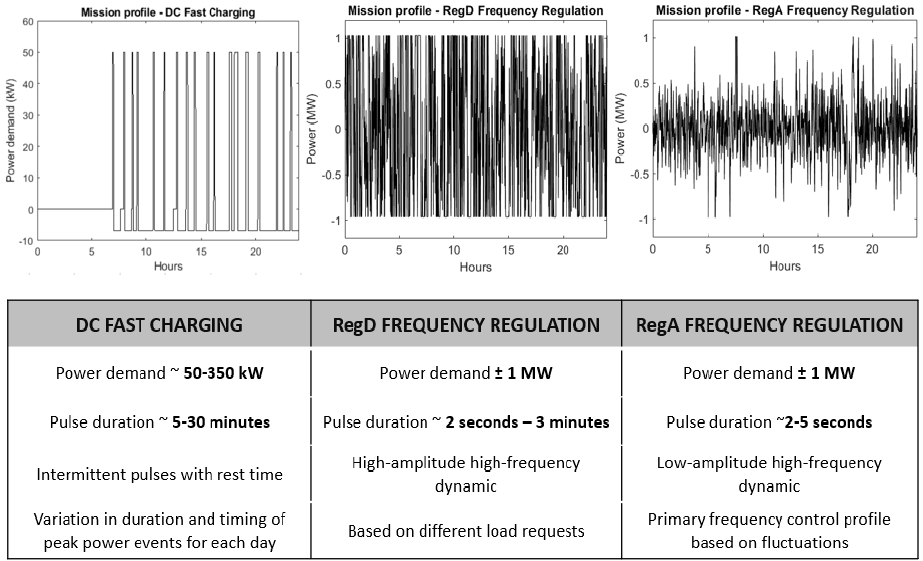
Figure 8. Second-life application power demand